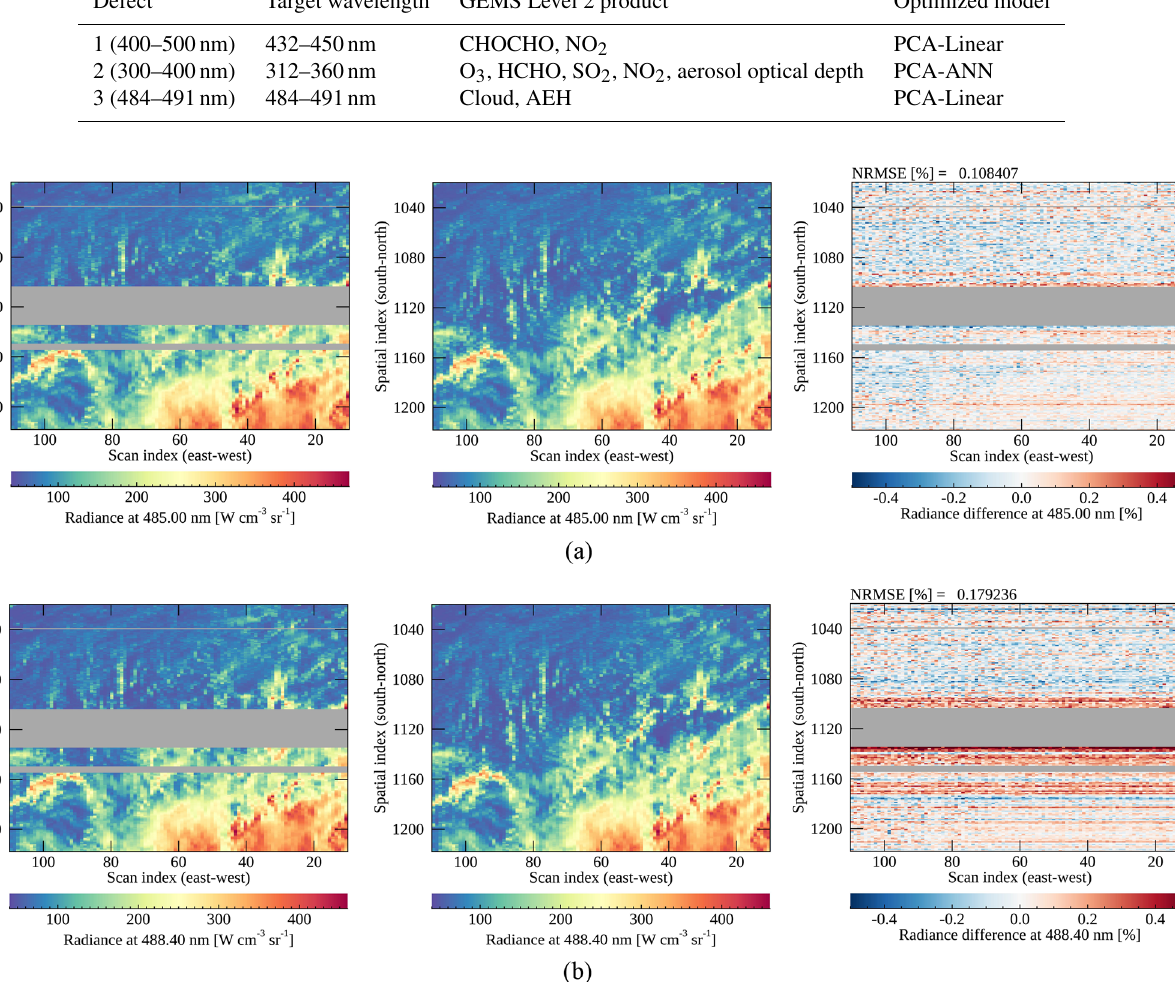
Figure 7. Spatial distribution of GEMS, ML radiances and the differences (from the first to the third column) at the wavelengths presenting (a) the smallest and (b) the largest differences for the Defect 3 area. The difference is calculated between the ML and GEMS radiances and divided by the latter in percent. Bad pixels are marked in dark gray, and the color bar range for differences is ± 0.5%. The unit of NRMSE is percent divided by mean